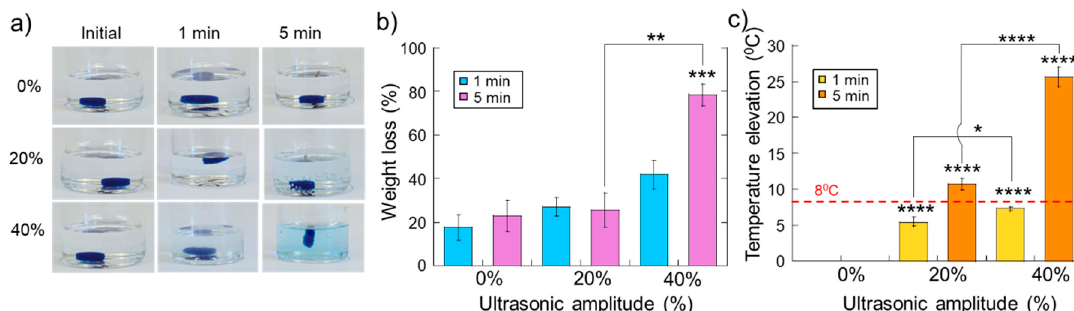
Figure 4. Ultrasound erodes and heats the gels in manners that are dependent on the intensity and duration of the applied ultrasound. ( a ) Photographs of mitoxantrone-loaded hydrogels after exposure to the US at the indicated amplitudes and durations. ( b ) Percent weight loss vs. US intensity for gels stimulated for 1 min (light blue) and 5 min (light purple). ( c ) Temperature elevation vs. US intensity for gels stimulated for 1 min (yellow) and 5 min (orange). *, **, ***, and **** indicate statistically significant differences with p < 0.05, 0.01, 0.001, and 0.0001, respectively, compared to controls (0% amplitude) unless otherwise specified with lines. N = 4.